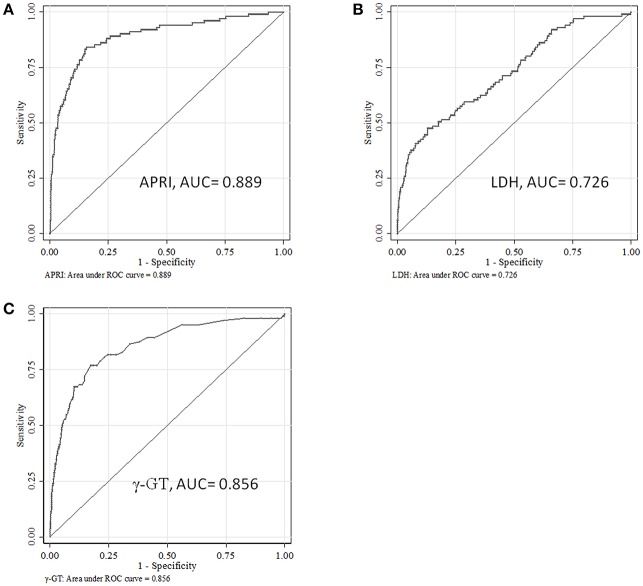
The ROC curves for APRI, LDH or γ-GT to predict the occurrence of sepsis-associated liver injury (SALI). (A) APRI, (B) LDH, and (C) γ-GT.